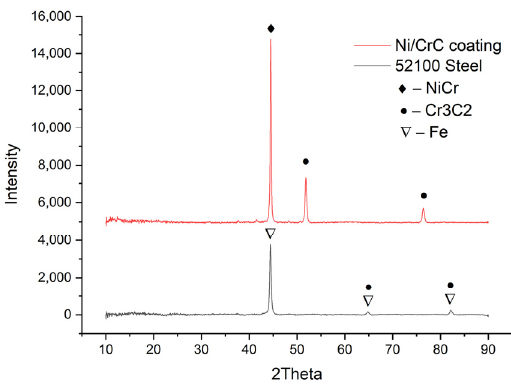
Figure 1. XRD pattern of coated sample and the base material.